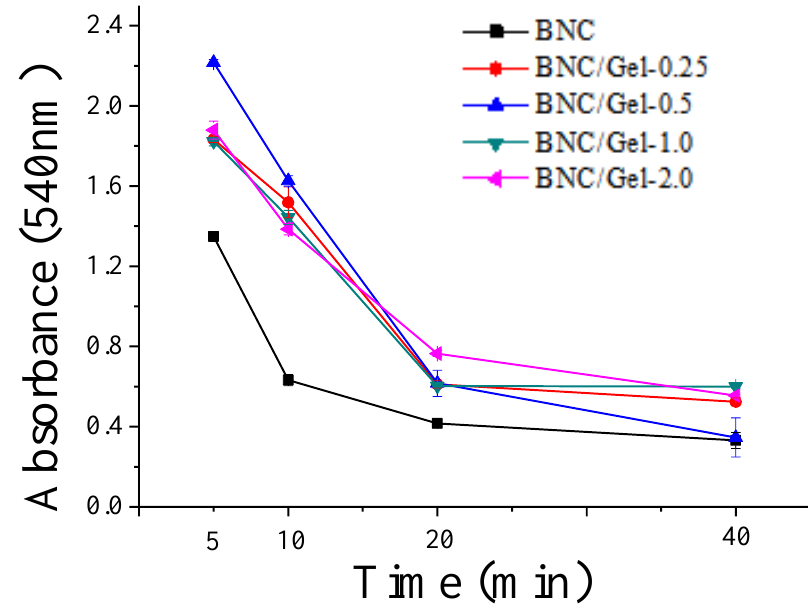
Figure 5. Whole blood clotting assay on the composite tubes.